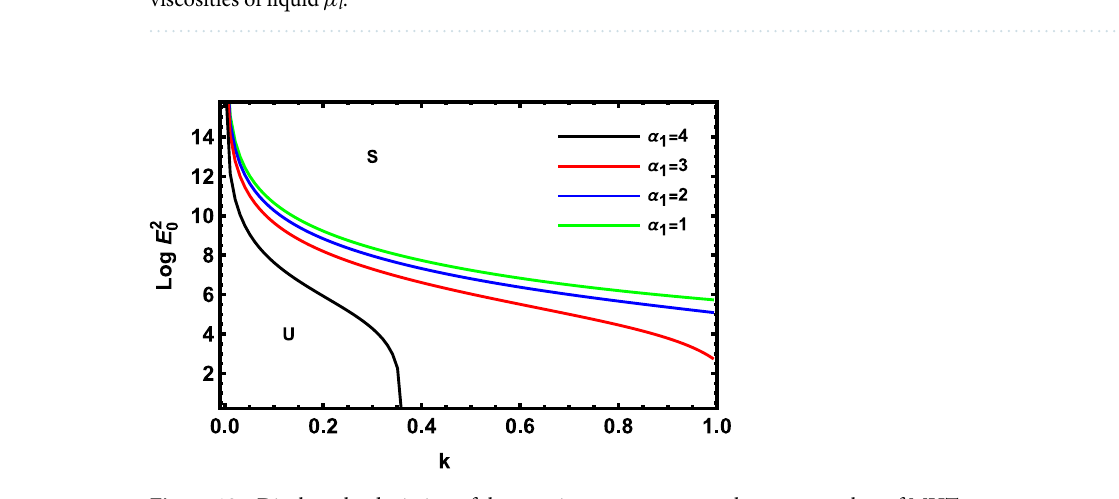
Figure 9. Displays the deviation of the growing amount versus the wave number of numerous standards for viscosities of liquid µ l .